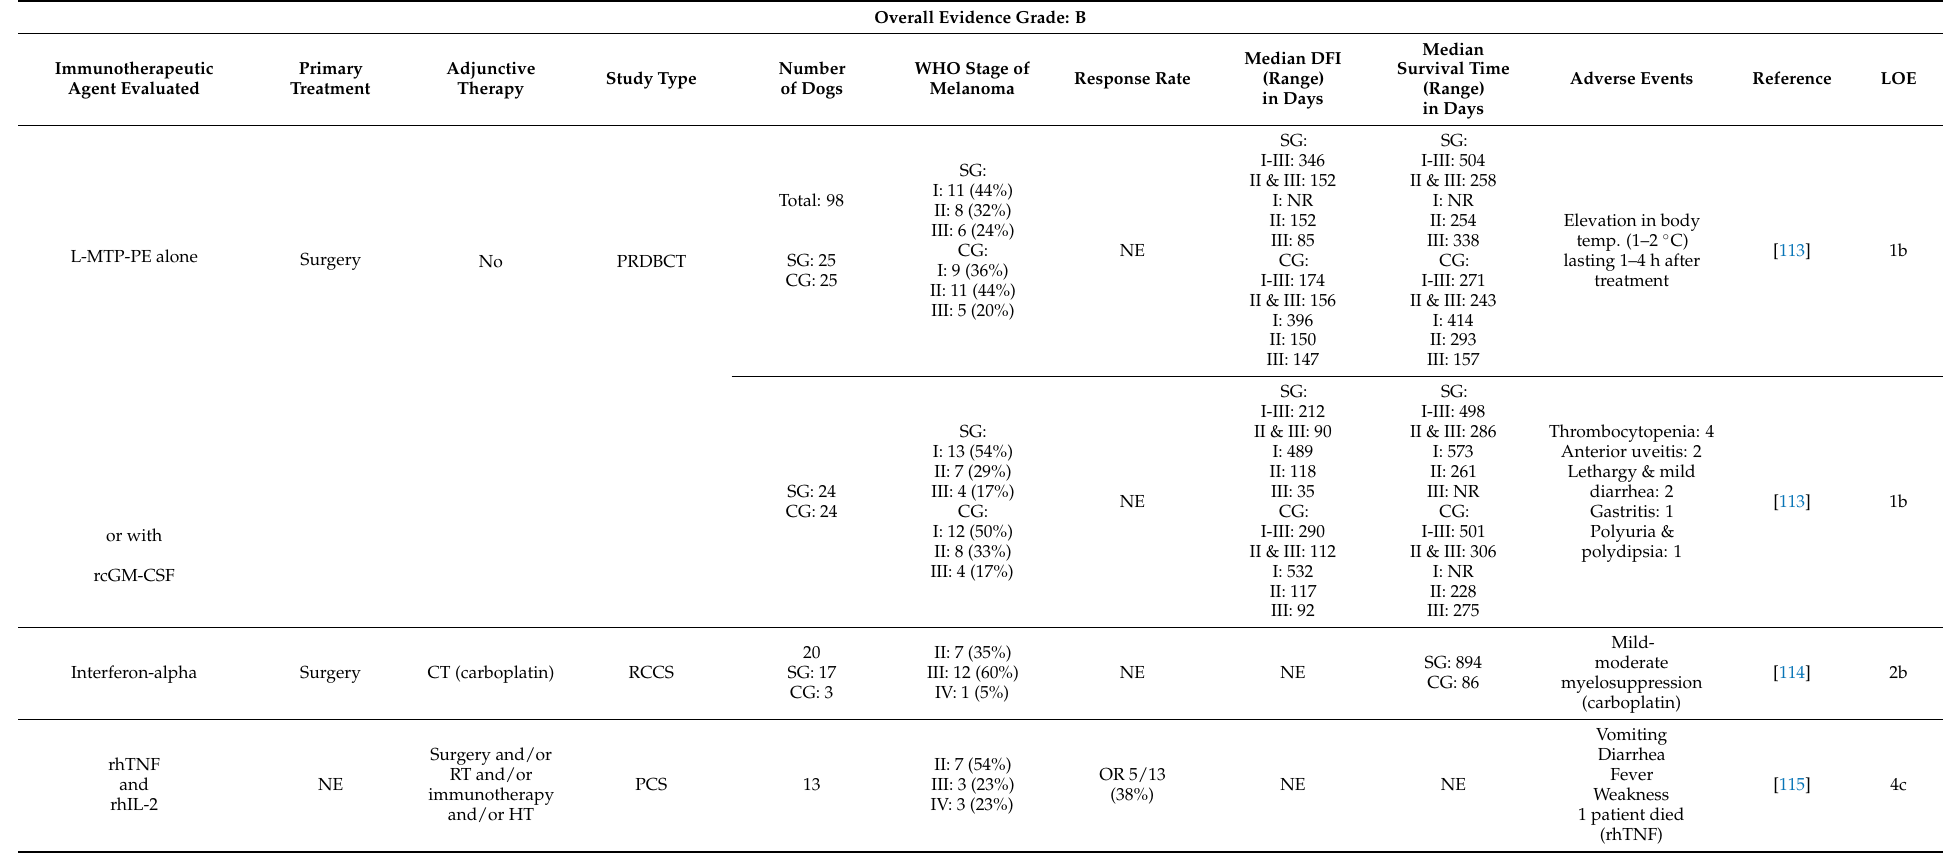
Table 16. Summary of stimulatory cytokine studies evaluating effectivity in oral malignant melanoma. Overall Evidence Grade: